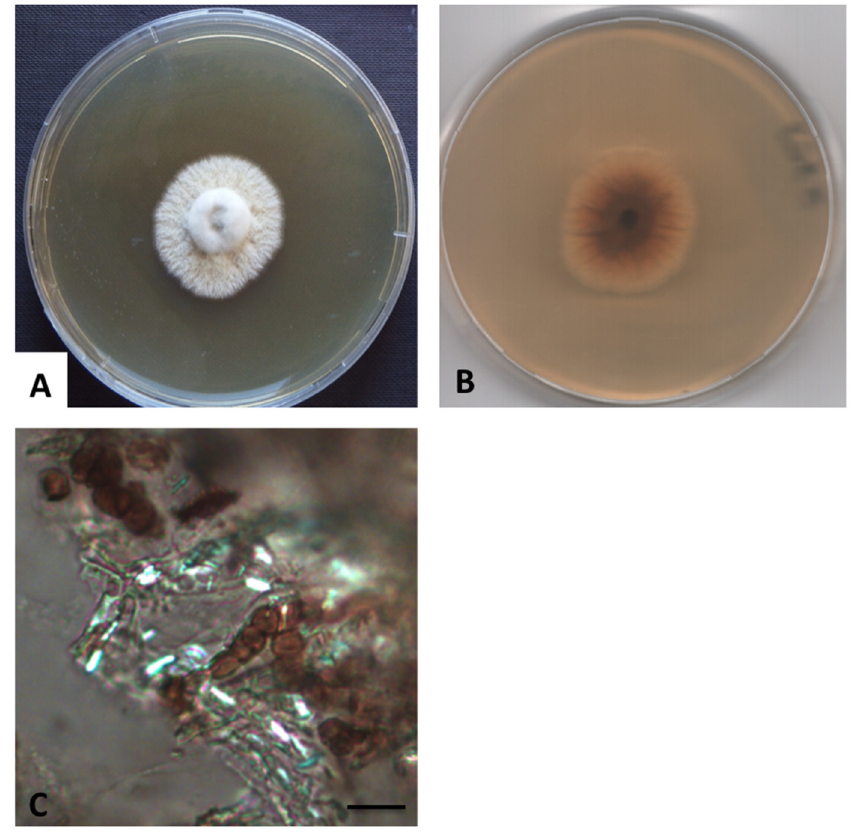
Figure 6. Roussoella margidorensis sp. nov. 28-days-old colony at 21 °C on MEASW ( A ) and reverse ( B ); chlamydospores ( C ). Scale bar: 10 µm.